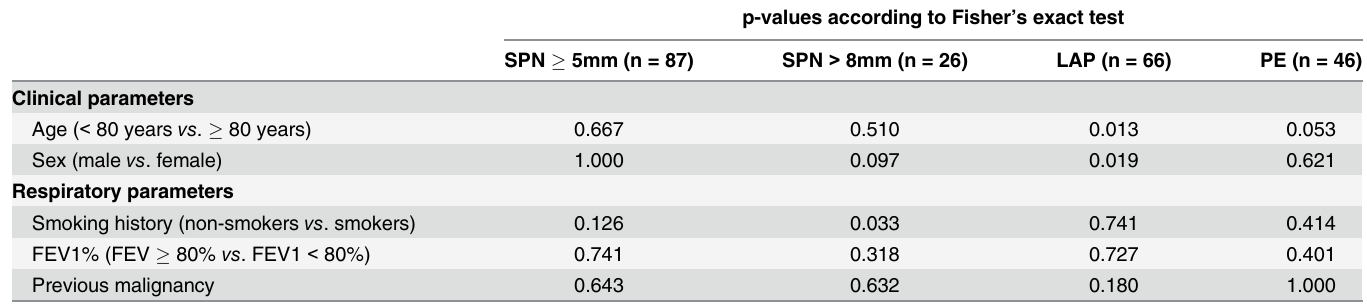
Table 3. Correlations of clinical and respiratory parameters with suspicious radiologic findings ( i . e . SPN, LAP and PE) for patients under TAVI evaluation with complete follow-up data (n = 237 patients). p-values according to Fisher ’ s exact